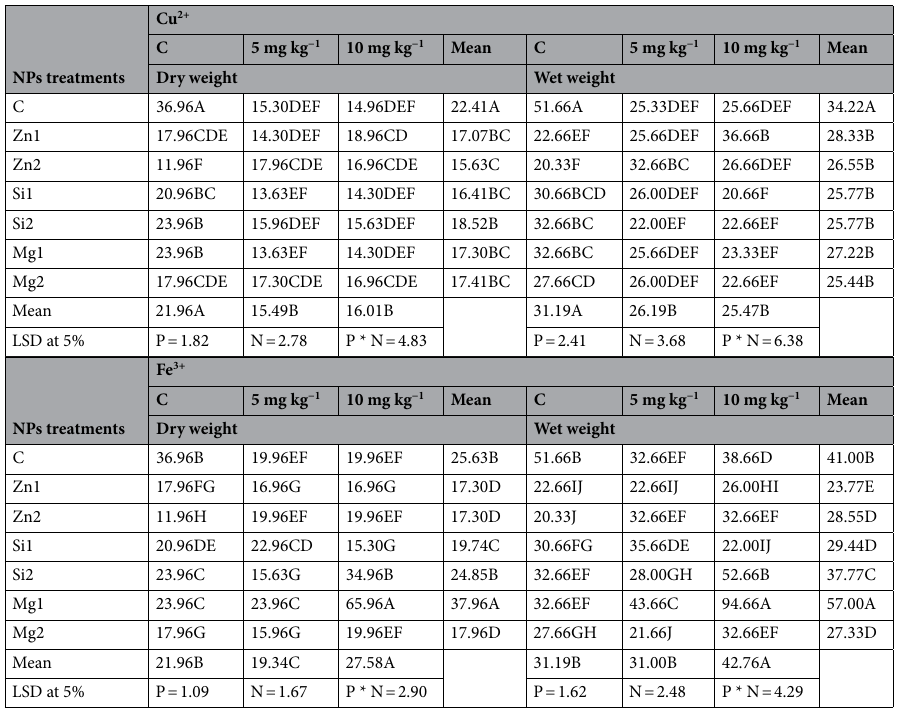
Table 7. Effect of different NPs and polluted water on dry and wet weights of Marjoram